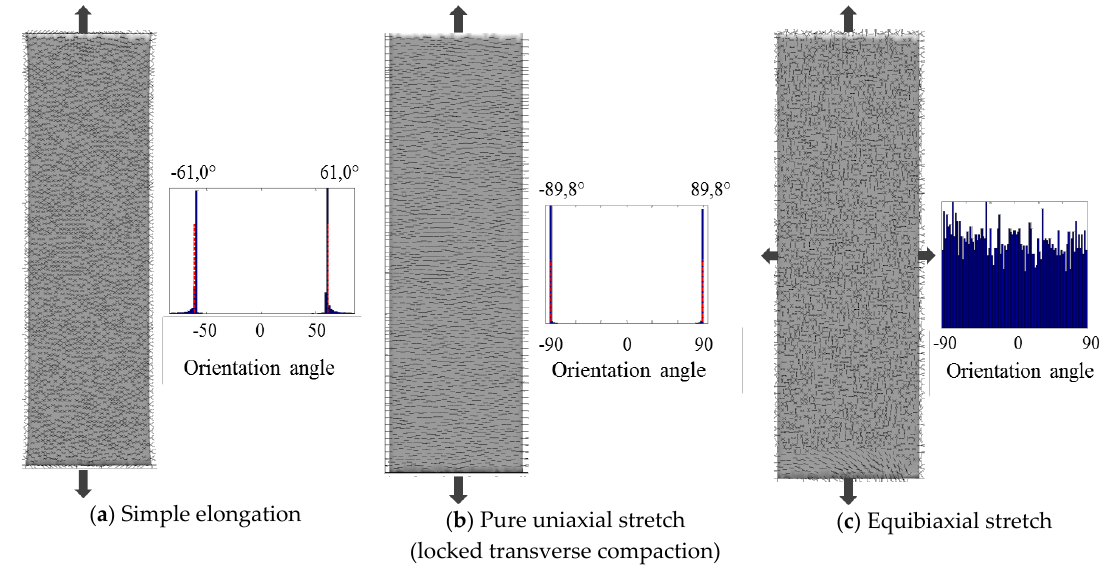
Figure 2. Computed preferential orientation of cells seeded on an elastic membrane under different stretch conditions. ( a ) Simple elongation (free transverse compaction); ( b ) Pure uniaxial stretch (locked transverse compaction); ( c ) Equibiaxial stretch. The results are in accordance with the reported results [11].